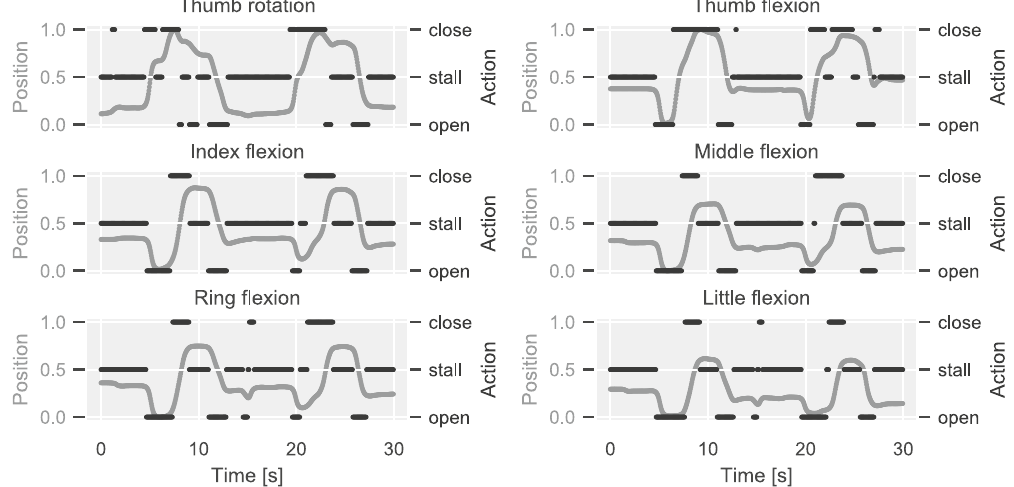
Figure 6. Finger action estimation from glove data. The mapping from position to action space is demonstrated using data from one participant. The position trajectory for each DOF (grey traces, left y-axes) is normalised between 0 (i.e., fully open) and 1 (i.e., fully closed). The first-order discrete position difference is computed and transformed into action via thresholding (black traces, right y-axes). The shown excerpt corresponds to two repetitions of the cylindrical grasp